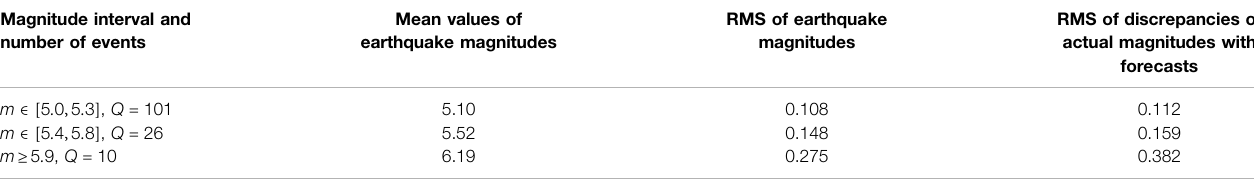
TABLE 4 | Results of forecasting the earthquake magnitudes for the Aegean Region. Magnitude interval and number of events